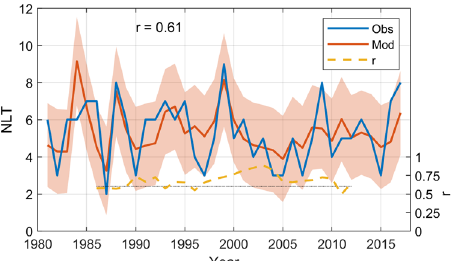
Fig. 5 Time series of number of tropical cyclones making landfall in South China (NLT). Observed value (blue) and cross-validated linear model prediction made using subNiño4 with 90% con fi dence bounds (orange). An 11-year rolling correlation coef fi cient ( r ) the two time series is shown in dashed yellow. The thin dashed line shows the r at which the 11-year rolling correlation is signi fi cant at the 95% con fi dence level using a two-tailed t - test ( r =